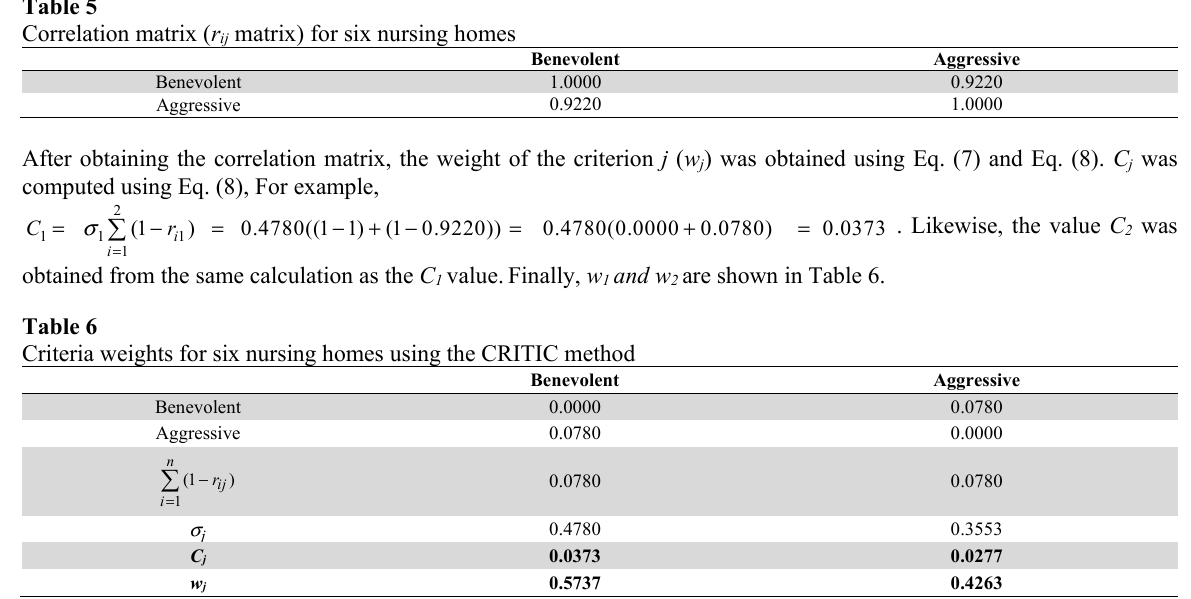
Correlation matrix ( r ij matrix) for six nursing homes